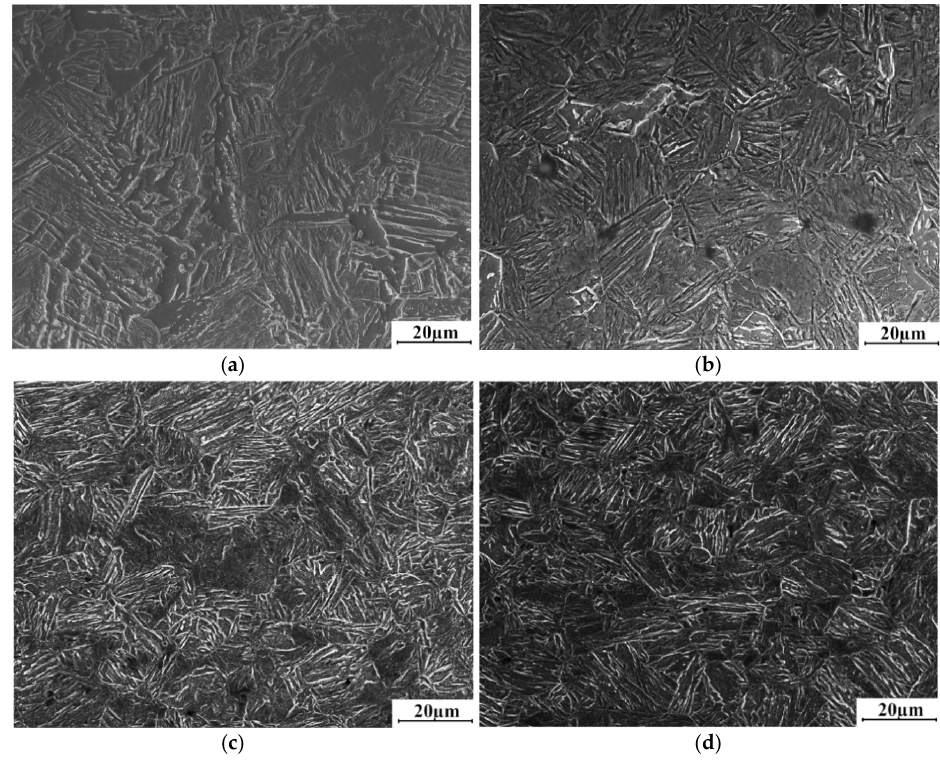
Figure 12. Microstructures of the part at locations 4 ( a ), 5 ( b ), 7 ( c ), and 8 ( d ) as labeled in Figure 10b.